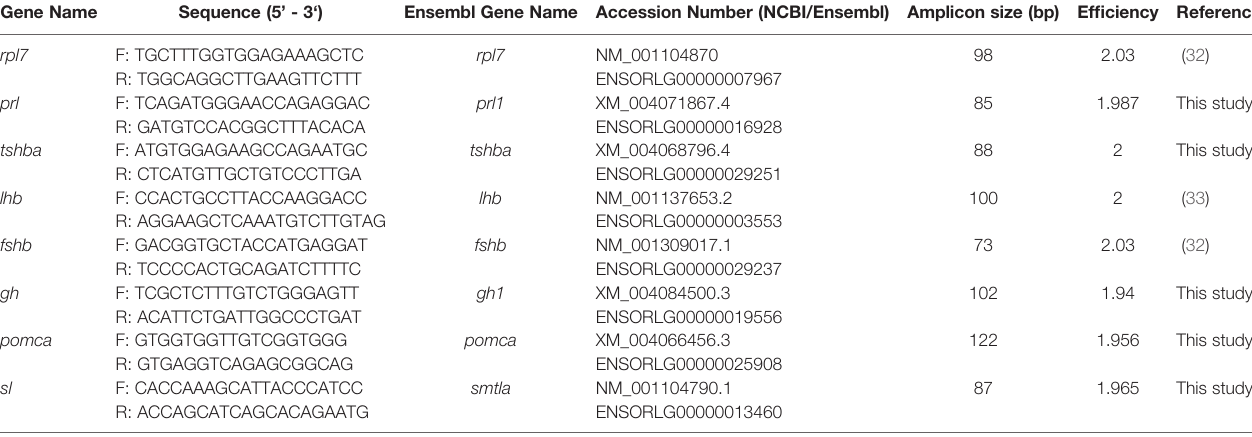
TABLE 1 | Primer sequences used for the mRNA level analysis in the medaka pituitary.